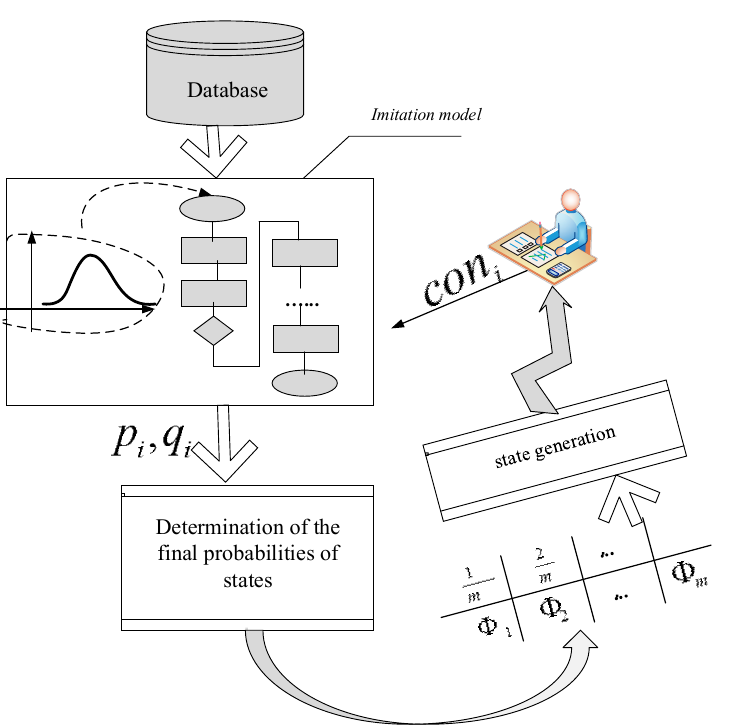
Figure 2. Interaction of automatic and simulation models in the implementation of the incentive function of inter-budget regulation.